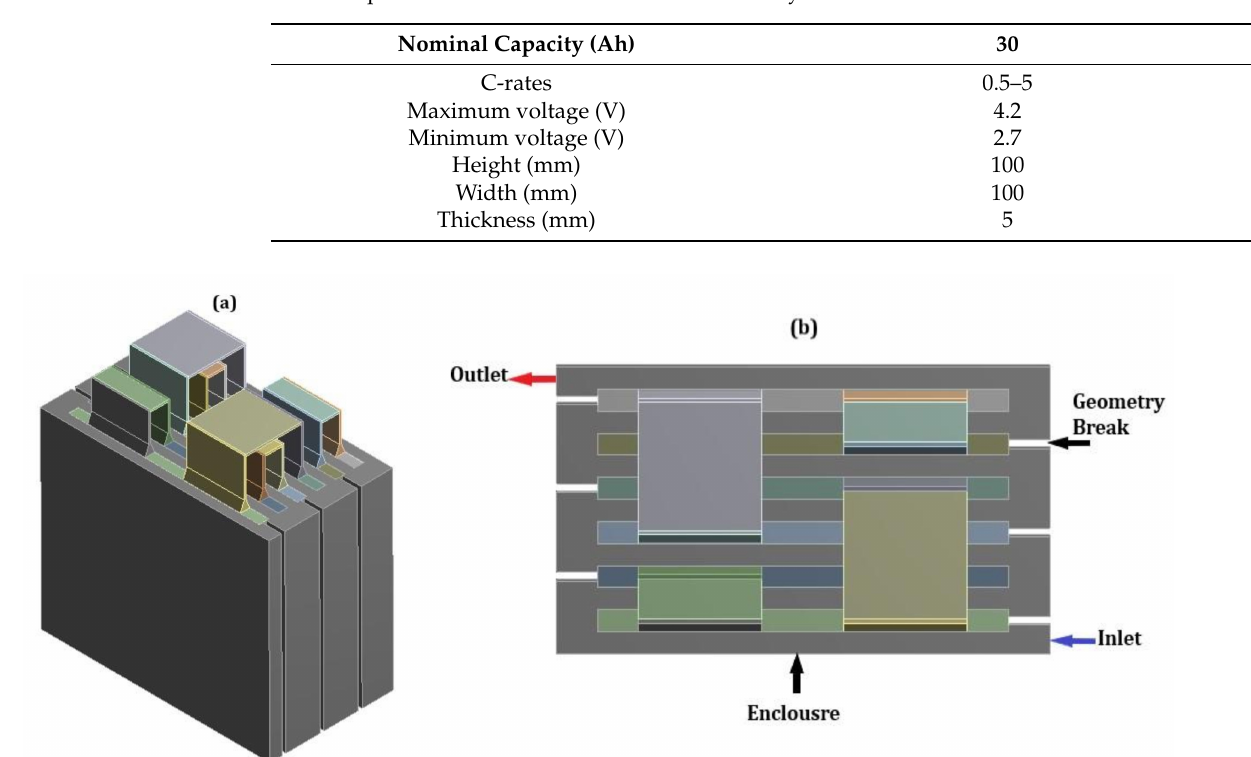
Table 2. Specifications of LIB Cells Used in this Study.